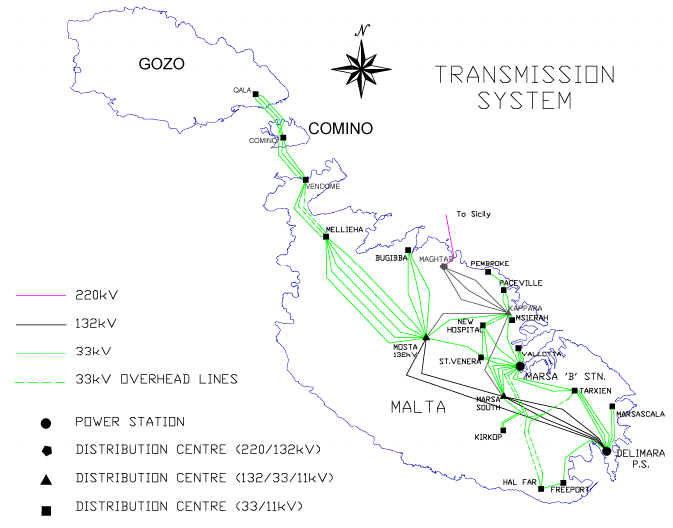
Figure 3. Electrical grid in Malta’s archipelago [17].